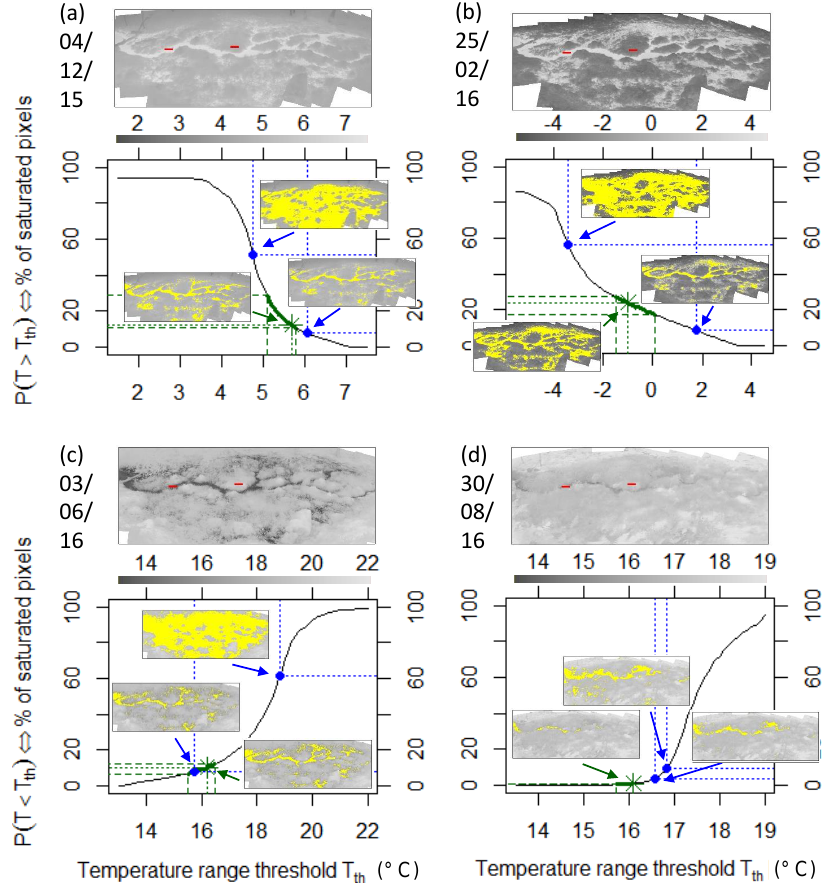
Figure 7. Example TIR images, with their cumulative saturation curves showing the percentage of pixels that have a higher (a, b) or lower (c, d) temperature than the temperature range threshold T th and are thus defined as saturated (marked as yellow pixels in the inset TIR images). The green asterisks mark the temperature ranges that were manually chosen as optimum following a visual assessment of the images. Green dashed lines define the uncertainty of the optimum temperature ranges. The red rectangles in the TIR images depict the masks used for the identification of temperature ranges from a constantly wet (a, c) and constantly dry (b, d) area. The respective temperature ranges and saturation percentages are marked in blue. As a reference for the spatial dimension of the images, we refer the reader to the indicated stream section in Figs. 3 or